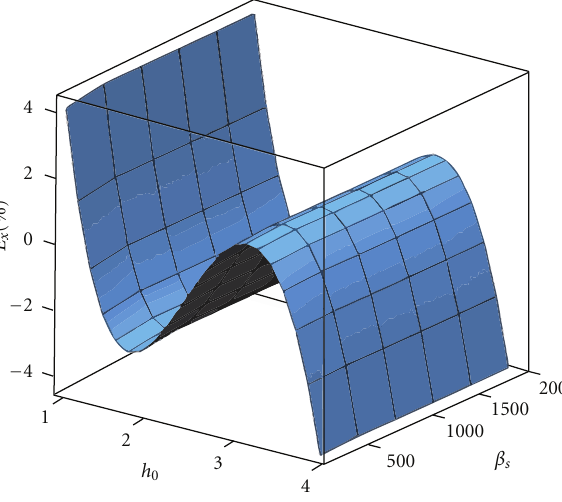
Figure 24: μ ( h 0 , a ) for β s = 500 and m = 2 × 10 − 5 .